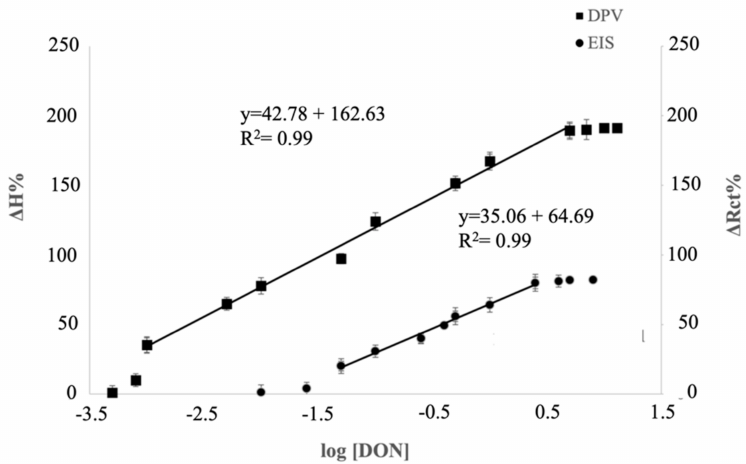
Figure 5. Calibration curve of DON immunosensor investigated through EIS (•) and DPV( ▪ ) trans- duction techniques.